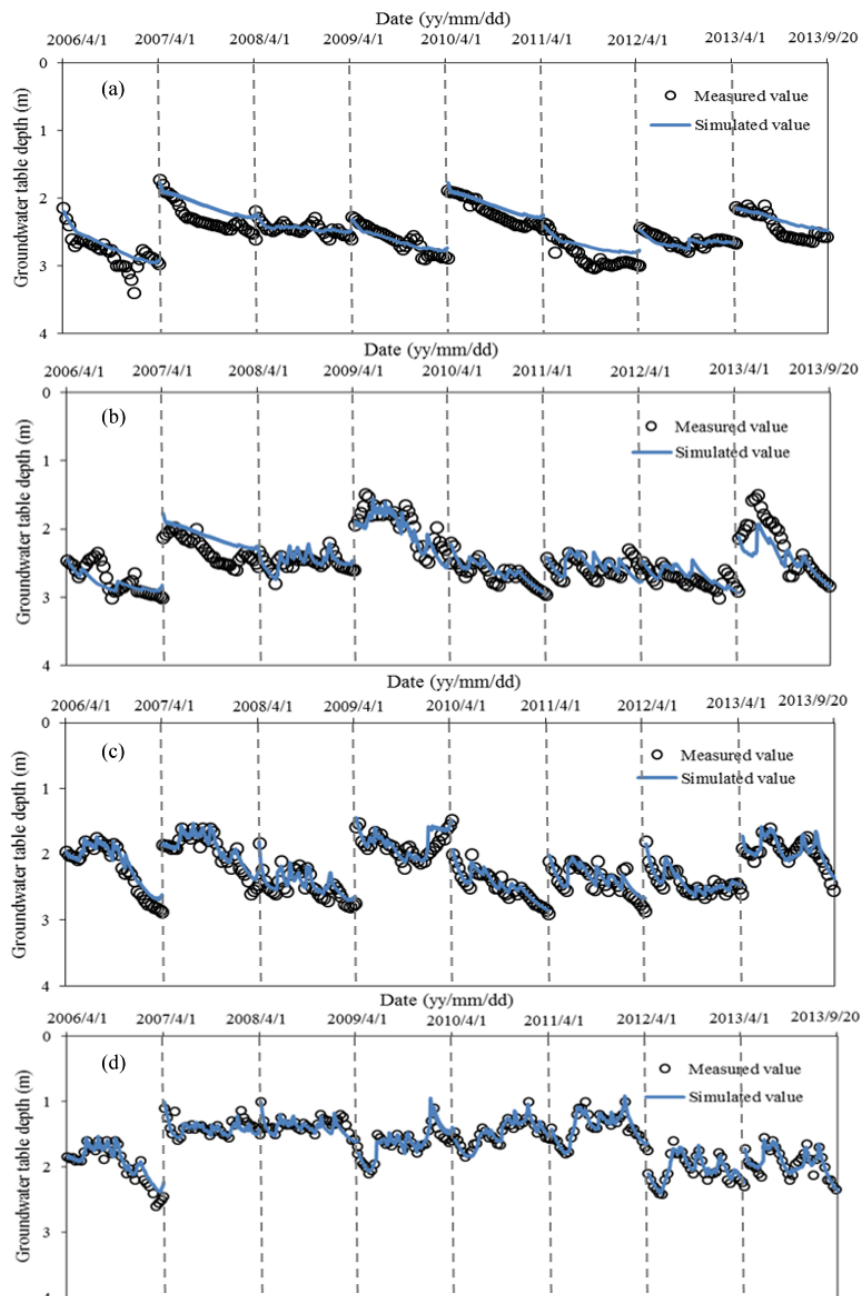
Figure 7. The comparison of the simulated and measured groundwater table depth for four typical sites during the crop growing season from 2006 to 2013. Panel (a) shows the uncultivated area from 2006 to 2013; panel (b) shows the uncultivated area from 2006 to 2008 and the sunflower field and maize field from 2009 to 2013; panels (c) and (d) show the sunflower, wheat, and maize fields from 2006 to